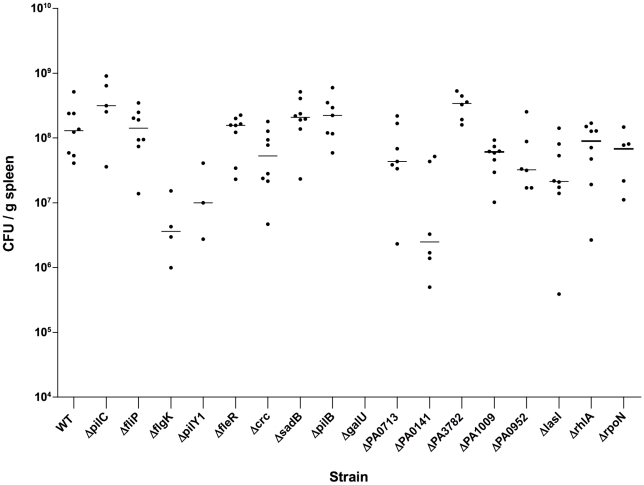
Viable counts of P. aeruginosa strains PA14 and PA14 Tn-mutants recovered from murine spleens.Points represent result from individual animals (female 6–8 wk-old C3H/HeN mice), and horizontal lines represent the medians. n = 6–8 for each strain (please refer to Table 3 for actual numbers for each mutant strain). Mice were initially colonized with PA14 and then subsequently made neutropenic with monoclonal antibody RB6-8C5 (0.200 mg IP once). Tn, transposon-insertion.